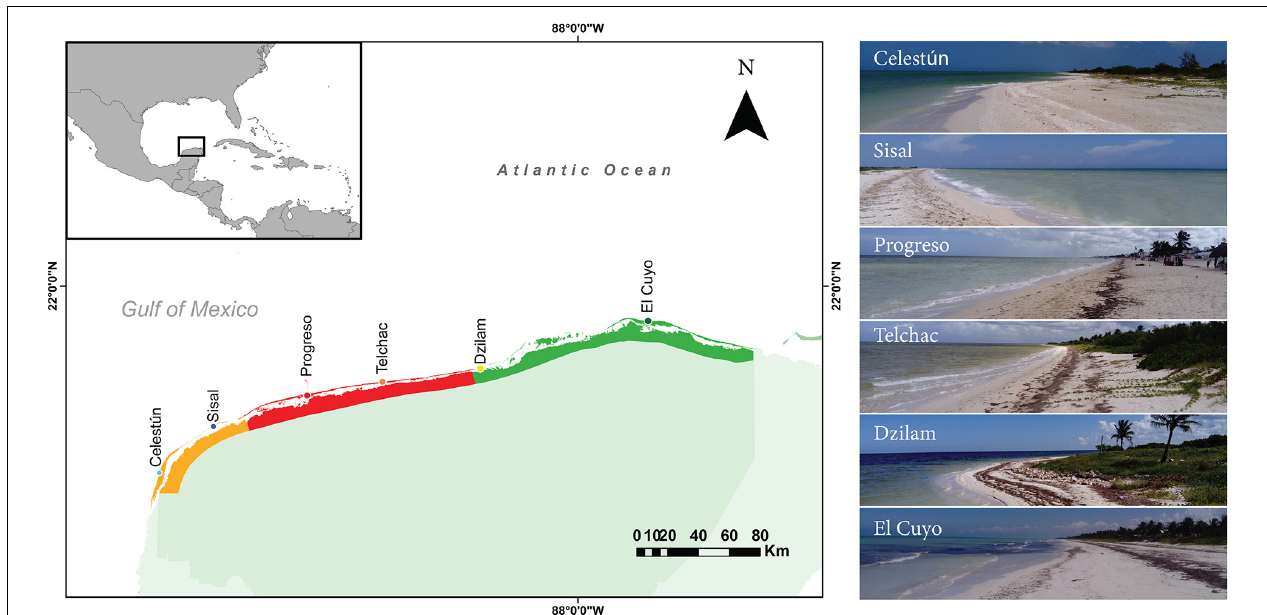
FIGURE 1 | Localities studied on the coast of Yucatán State, México. Three portions of the coast are colored according to environmental health (sensu LANRESC, 2017): orange (regular), red (poor), green (good). For each locality, three sites distance apart by 3–9 km were sampled. Also, for each locality, a picture of the beach is